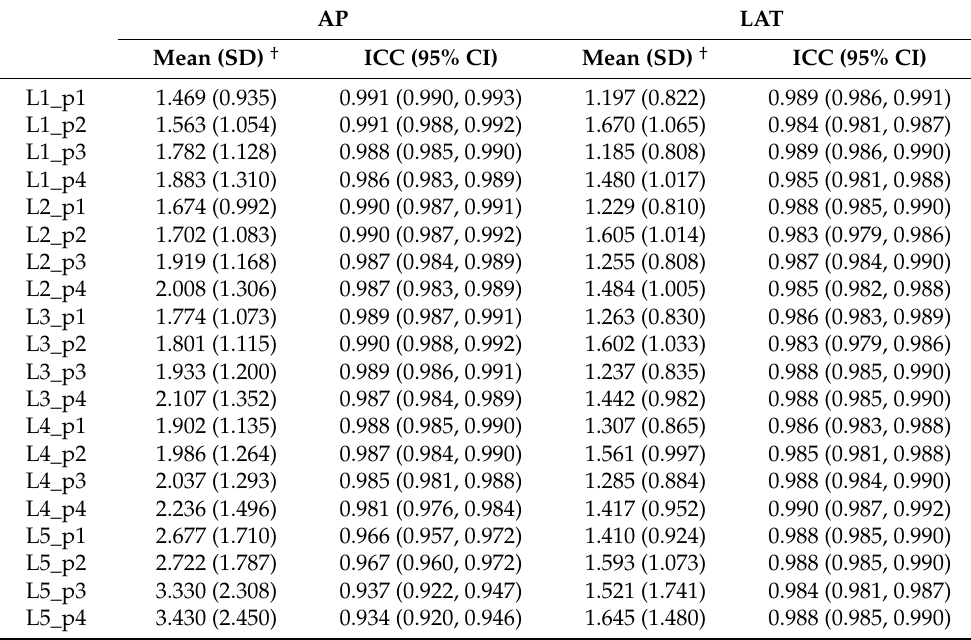
Table 2. Mean variations and inter-rater reliability of landmark points assessed by all 12